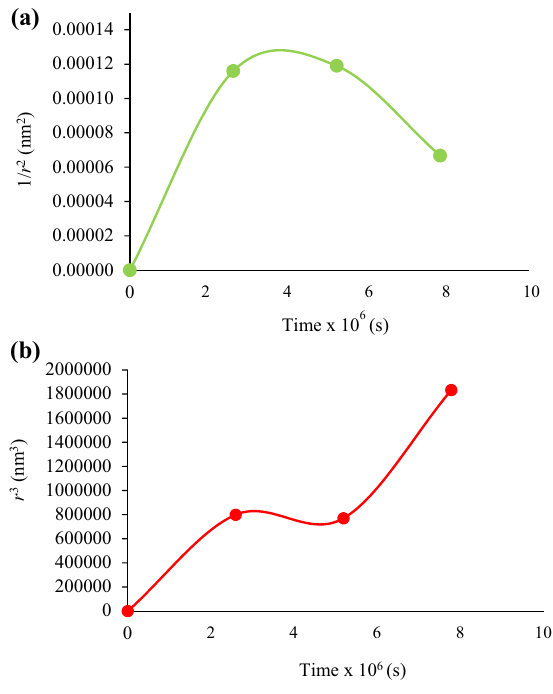
Figure 2. ( a ) Rate of coalescence and ( b ) Rate of Ostwald ripening graphs in terms of MDS (mean droplet size) for the optimal nanoemulsion under 90 days of storage at 25